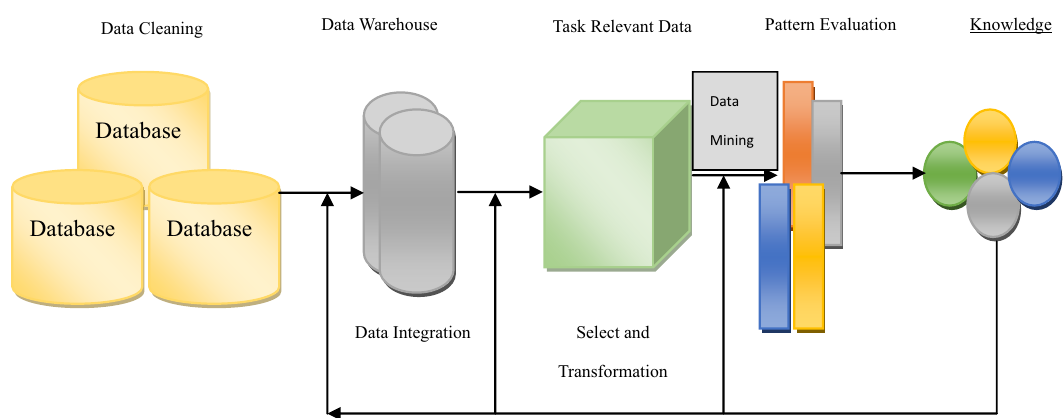
Figure 1: Basic diagram of data mining steps in